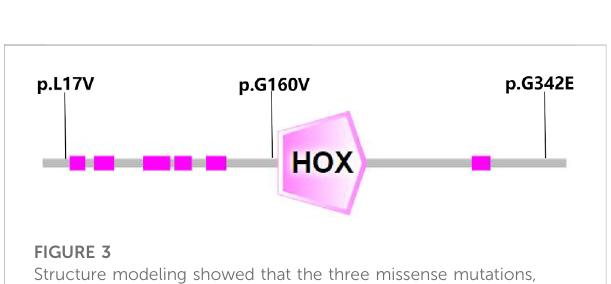
FIGURE 3 Structure modeling showed that the three missense mutations, p.G160V, p.G342E and p.L17V, were located in the functional domain of the VSX1